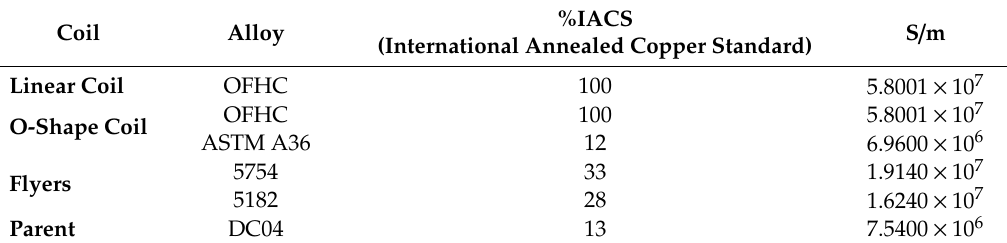
Table 8. Electrical Properties—International Annealed Copper